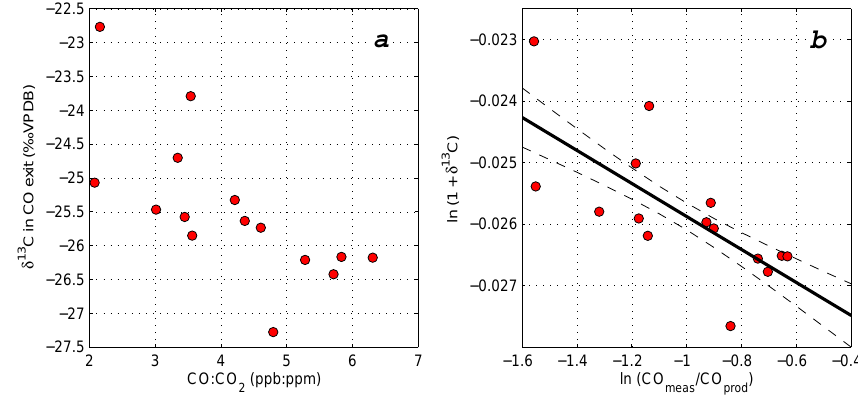
Fig. 5. (a) δ 13 C in CO at the exit site, averaged for each sampling action, plotted against the CO:CO 2 ratios computed for the same sampling action. (b) Rayleigh plot used to determine the fractionation during CO destruction. The slope of the linear fit gives the fractionation constant ε . The dashed lines represent the 68% confidence bounds for the linear